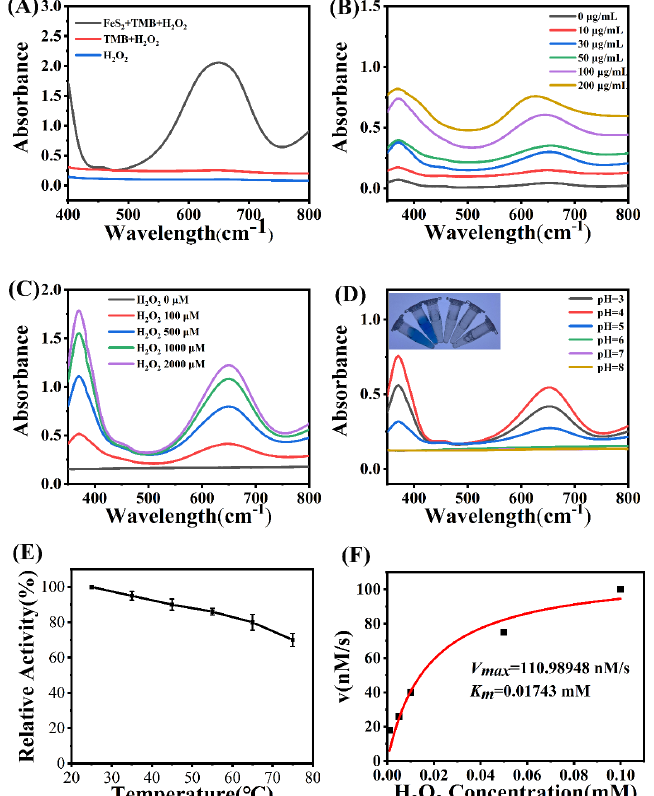
Figure 3. ( A ) UV − vis absorbance spectra changes of TMB in different reaction systems. ( B ) UV − vis absorbance spectra changes of TMB in different concentrations of FeS 2 . ( C , D ) UV − vis absorbance spectra changes of TMB in different concentrations of H 2 O 2. ( E ) The effect of temperature on the catalytic activity of POD-like FeS 2 . ( F ) Kinetic assay for the POD-like activity of FeS 2 nanozymes with H 2 O 2 as substrate.